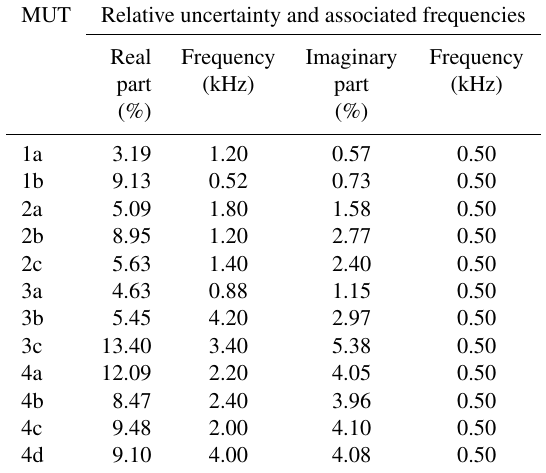
classification of material compositions and material